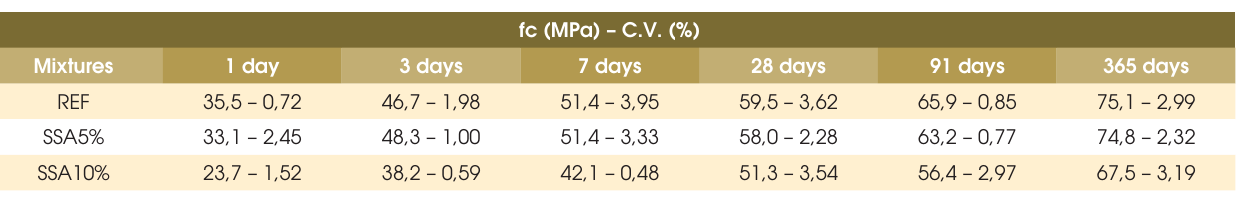
Table 3 – Compressive resistance (MPa) for REF, SSA5% and SSA10% mixture